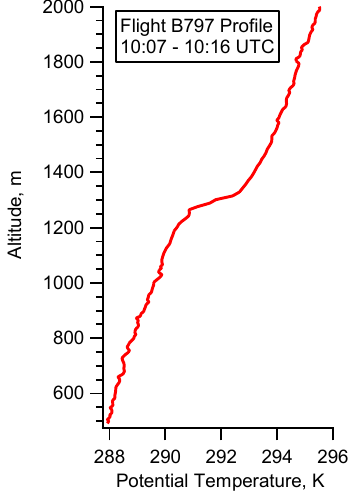
Figure 2. The potential temperature change experienced during flight B797’s ascent at time 10:07–10:16 UTC, where a large temperature increase is observed at ~1310 m altitude.